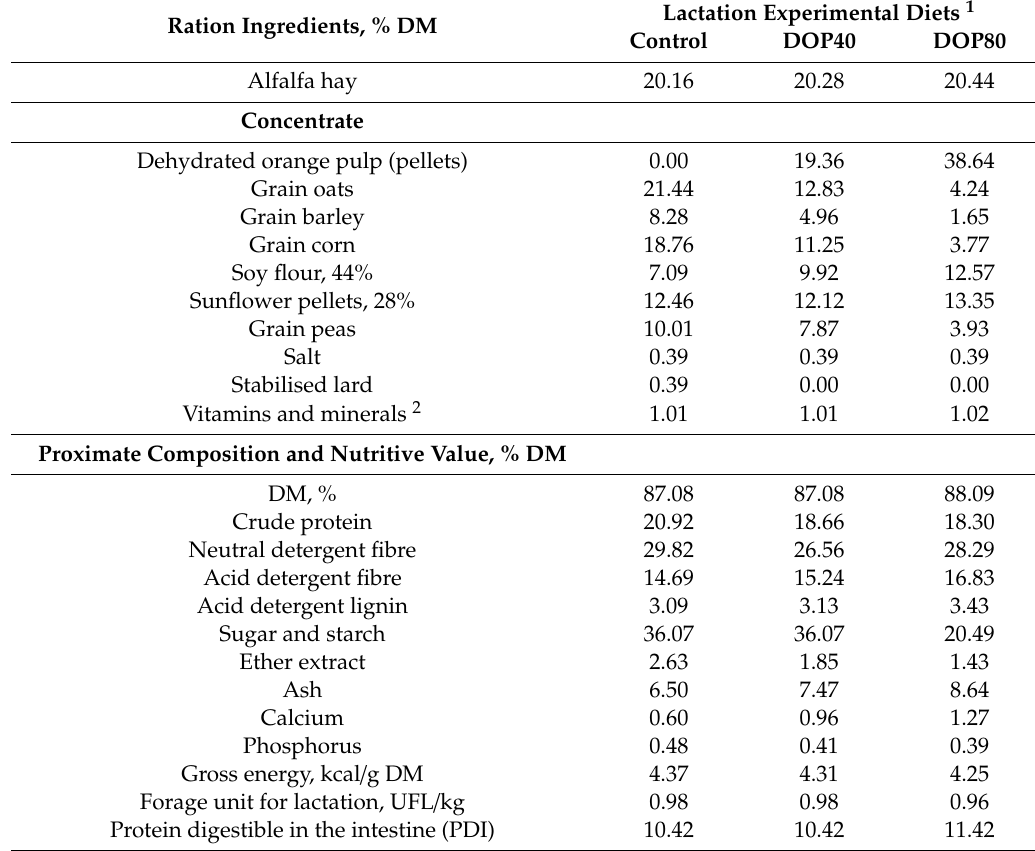
Table 1. Ration ingredients, proximate composition, and nutritive value of the experimental diets used to feed goats during the fifth month of